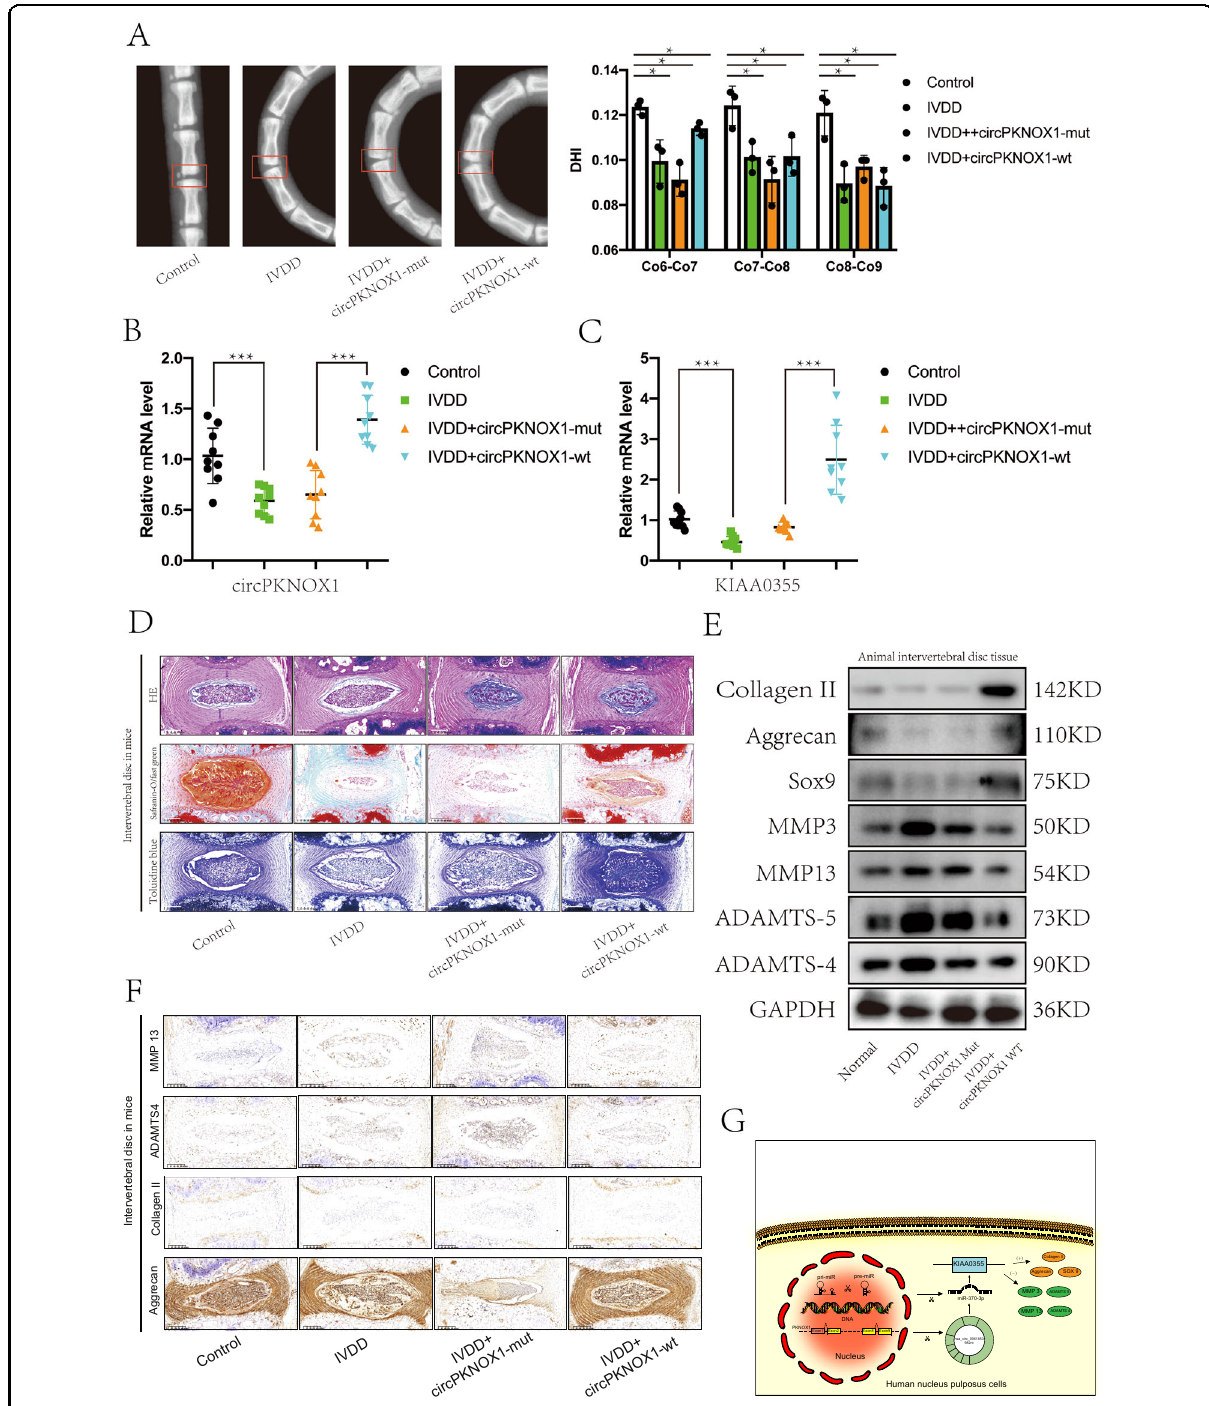
Fig. 6 In the animal model, the circPKNOX1/miR-370-3p/ KIAA0355 axis promoted IVDD development. A Left: the tails of the mice were examined using X-ray imaging analysis. Right: the disc height index of the tails of the mice was quantitatively analyzed; * P <0.05. Data represent mean±SD, and the P values were determined by a two-tailed unpaired Student ’ s t test. B The expression of circPKNOX1 was detected using RT-qPCR; *** P <0.001. Data represent mean±SD, and the P values were determined by a two-tailed unpaired Student ’ s t test. C The expression of KIAA0355 was detected using RT- qPCR; *** P <0.001. Data represent mean±SD, and the P values were determined by a two-tailed unpaired Student ’ s t test. D The intervertebral disc tissue of mice was observed using hematoxylin and eosin, Safranin-O/fast green, and toluidine blue staining (scale bar, 200 μ m). E In the control, IVDD, circPKNOX1- mut, and circPKNOX1-wt groups, the expression of related proteins (collagen II, aggrecan, SOX9, MMP3, MMP13, ADAMTS4, and ADAMTS-5) was detected using western blotting. F Sections of the discs were analyzed using immunohistochemical staining for collagen II, aggrecan, ADAMTS4, and MMP13 (scale bar, 200 μ m). G The mechanism of action of